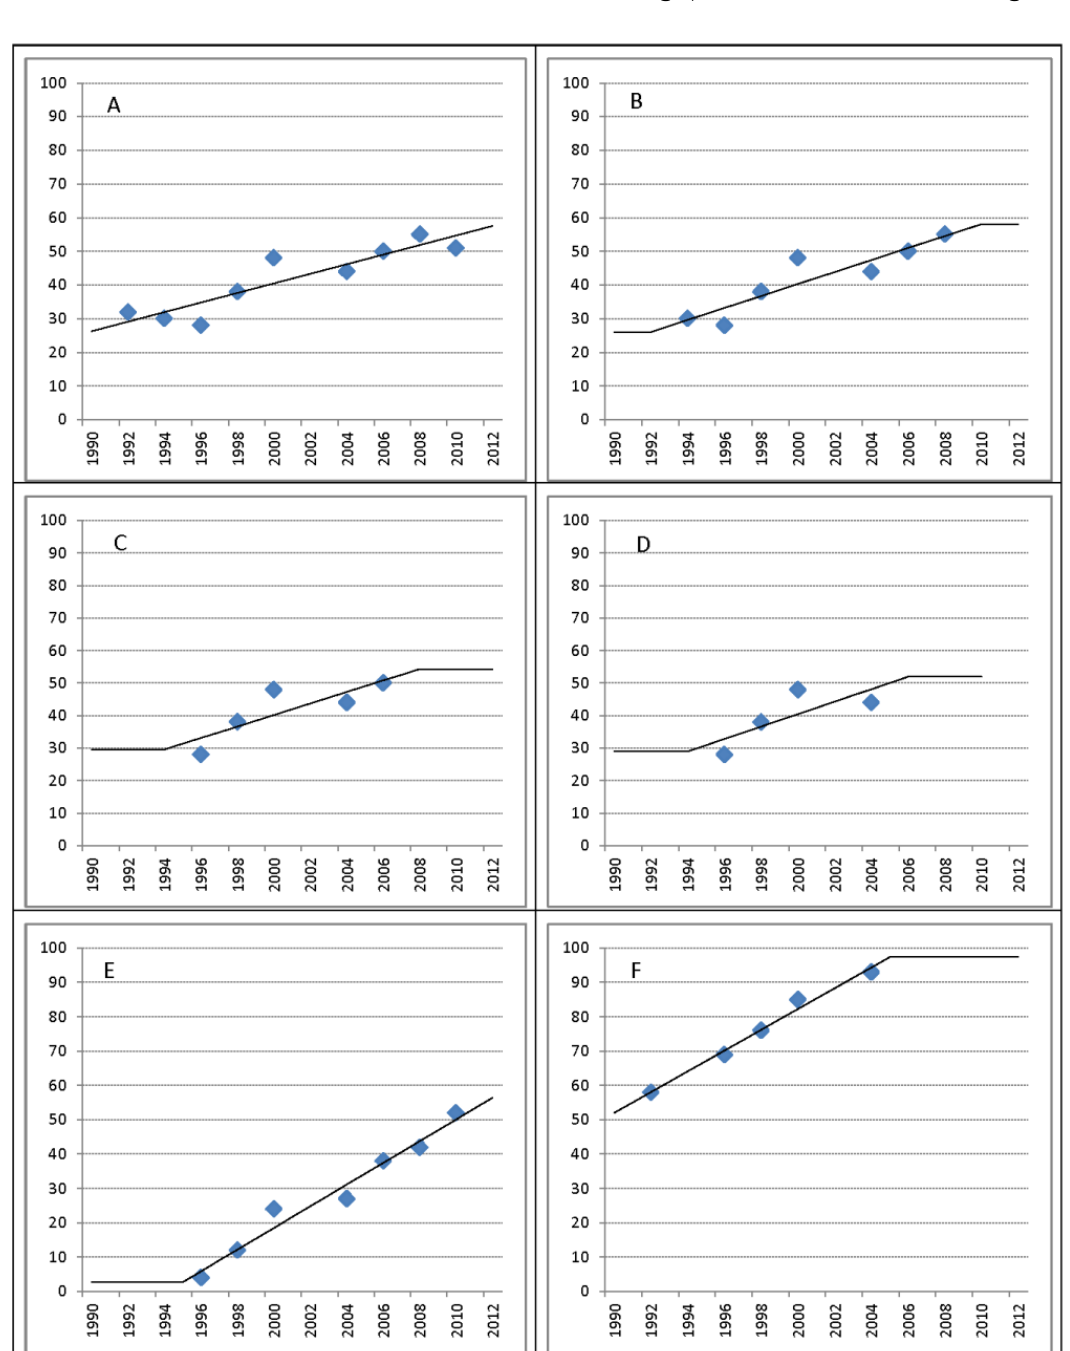
Figure 2. Illustration of JMP regression line extrapolations for countries with missing